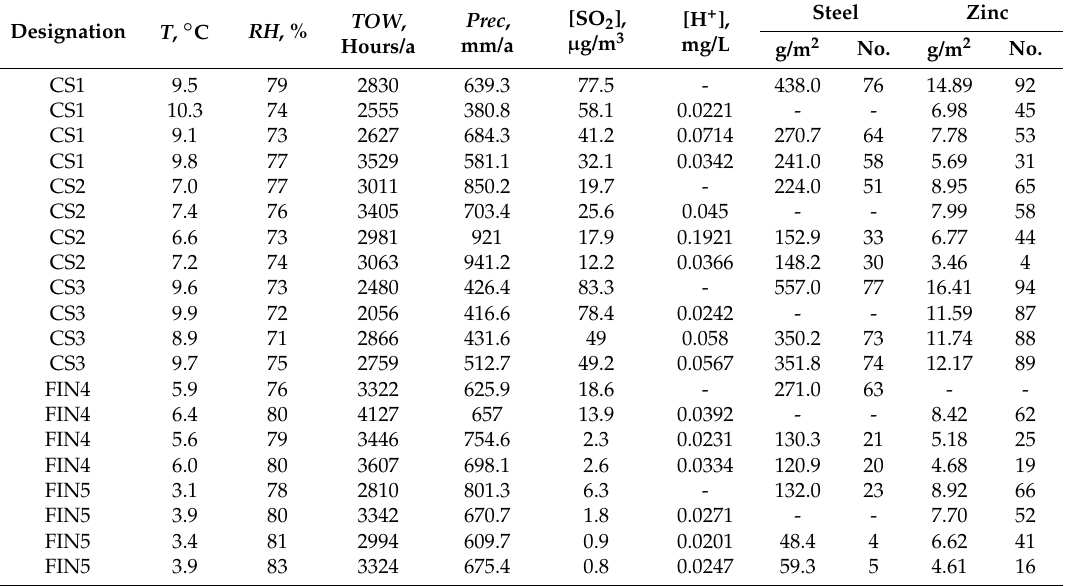
Table 2. Atmosphere corrosivity parameters of test locations, first-year corrosion losses of carbon steel and zinc ( K 1 , g/m 2 ) under the UN/ECE program, and numbers of test locations in the order of increasing K 1